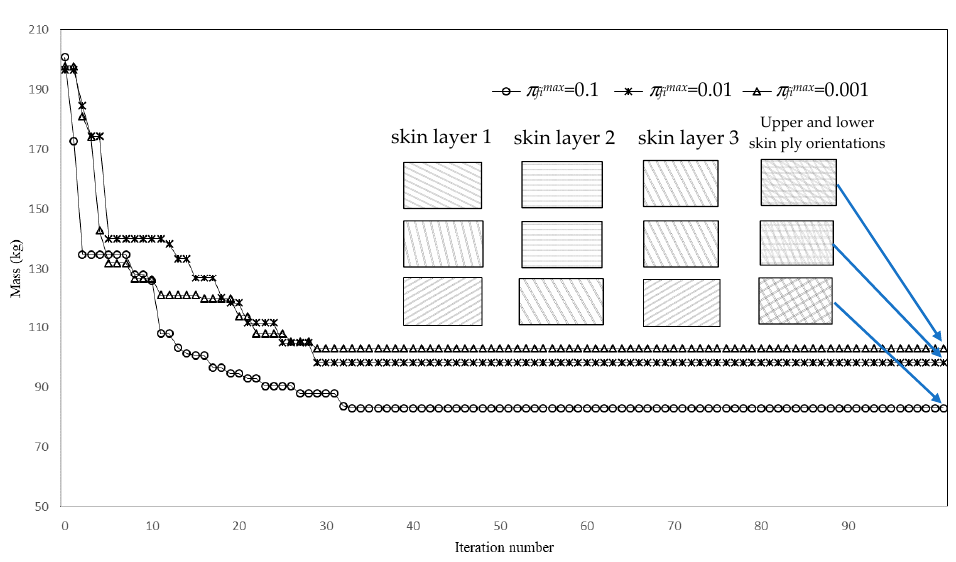
Figure 4. The search history of the composite aircraft wing design.